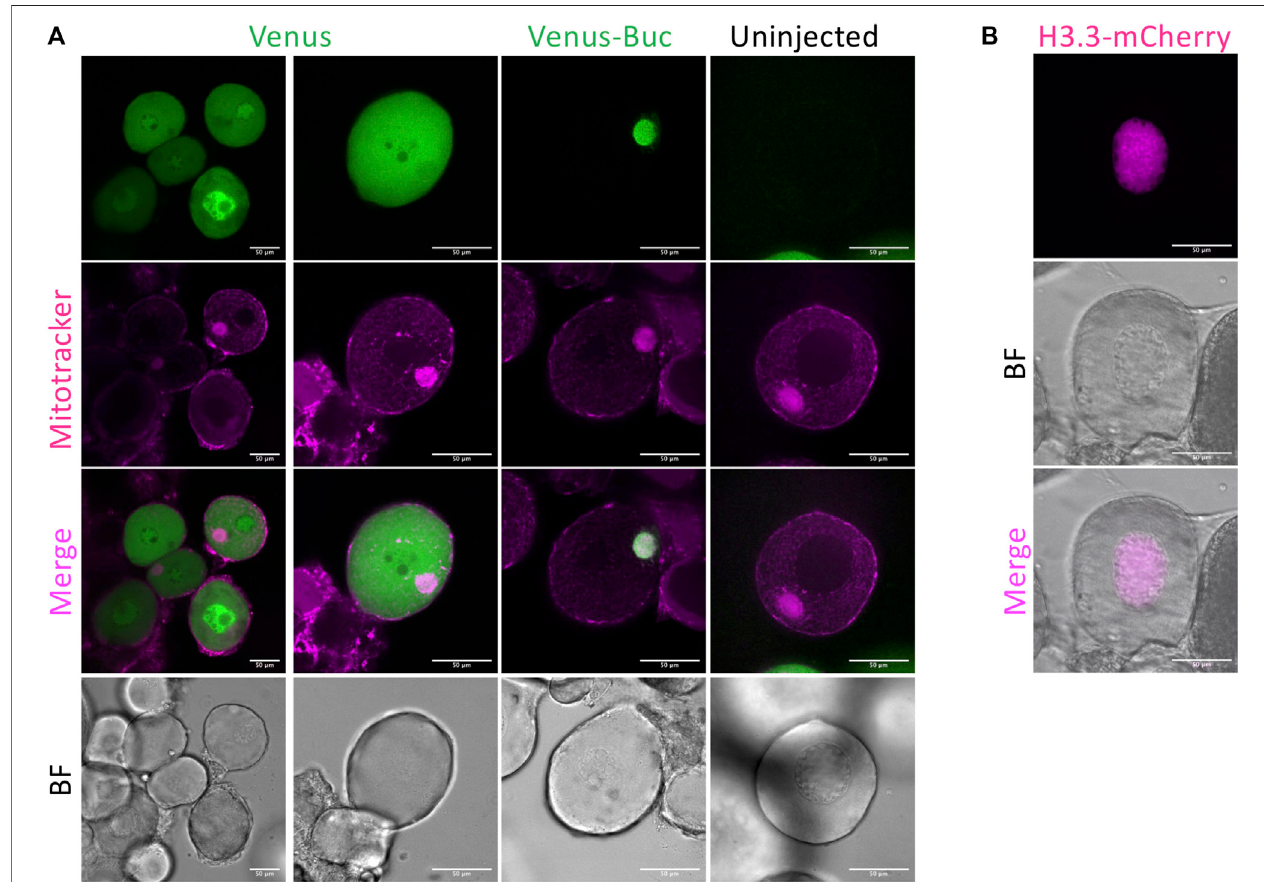
FIGURE2 | Representative data ofoocyte injection. (A) venus and venus-buc mRNAinjected oocyte. Mitotracker Red wasused forstainingmitochondria and the mitochondrial-rich structure called the Balbiani body (Bb) in stage 1 oocytes. Ubiquitous fl uorescence was observed in venus mRNA injected oocytes, and Venus-Buc was detected localized to the Bb in venus-buc mRNA injected oocytes but not in uninjected ones. (B) H3.3-mcherry injected oocyte. Histone H3.3 is a nuclear protein localized to the nucleus. H3.3-mCherry was detected in the nucleus of an H3.3-mcherry injected oocyte. BF (cid:2) bright fi eld. Scale bar (cid:2) 50 μ m.